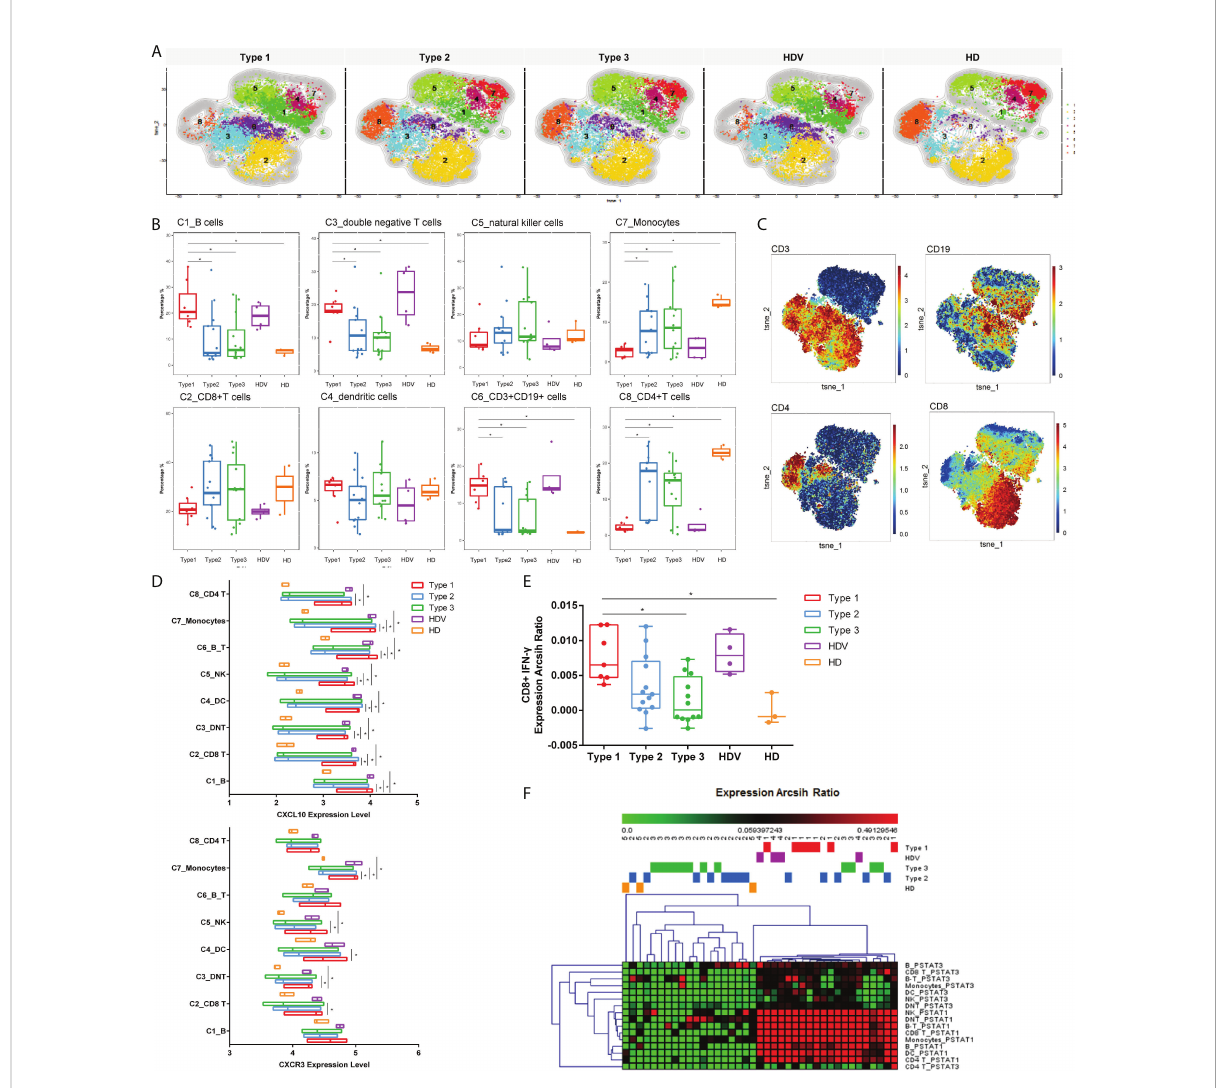
FIGURE 3 Innate immune responses induced by inactivated vaccination among LT recipients. (A) CyTOF-identi fi ed cell clusters from PBMCs visualized by t-distributed stochastic neighbor embedding (t-SNE). (B) Percentage of each cluster among fi ve groups. Boxes represent interquartile ranges (IQRs). Each dot represents an individual group: Type 1 (red), Type 2 (blue), Type 3 (green), HDV (purple), or HD (orange). (C) viSNE projections of expression of the indicated proteins. (D) The expression level of CXCL10 and CXCR3 in eight cell clusters. Line at median of groups. (E) IFN- g expression levels measured and compared among fi ve groups in CD8+ cells. (F) Heatmap of expression arcsih ratio of pSTAT3 and pSTAT1 levels. Signi fi cance was determined using Kruskal – Wallis test, followed by multiple pairwise comparisons. Statistical signi fi cance was set at a two-sided p -value <0.05 and adjusted p < 0.05. * p < 0.05. LT, liver transplant; PBMCs, peripheral blood mononuclear cells; HDV, healthy donors vaccinated with the inactivated vaccine; HD, healthy donors without